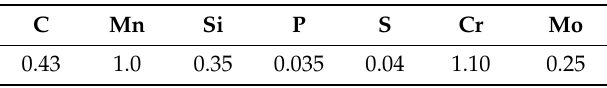
Table 1. Chemical analysis of CrMo-steel (in